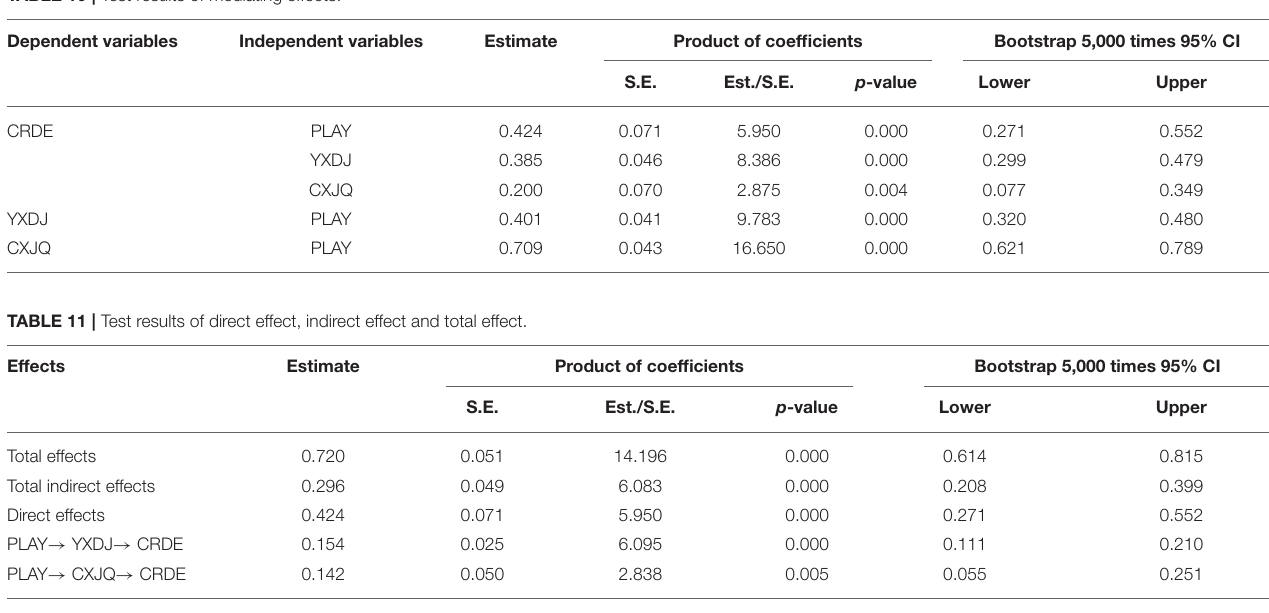
TABLE 10 | Test results of mediating effects.